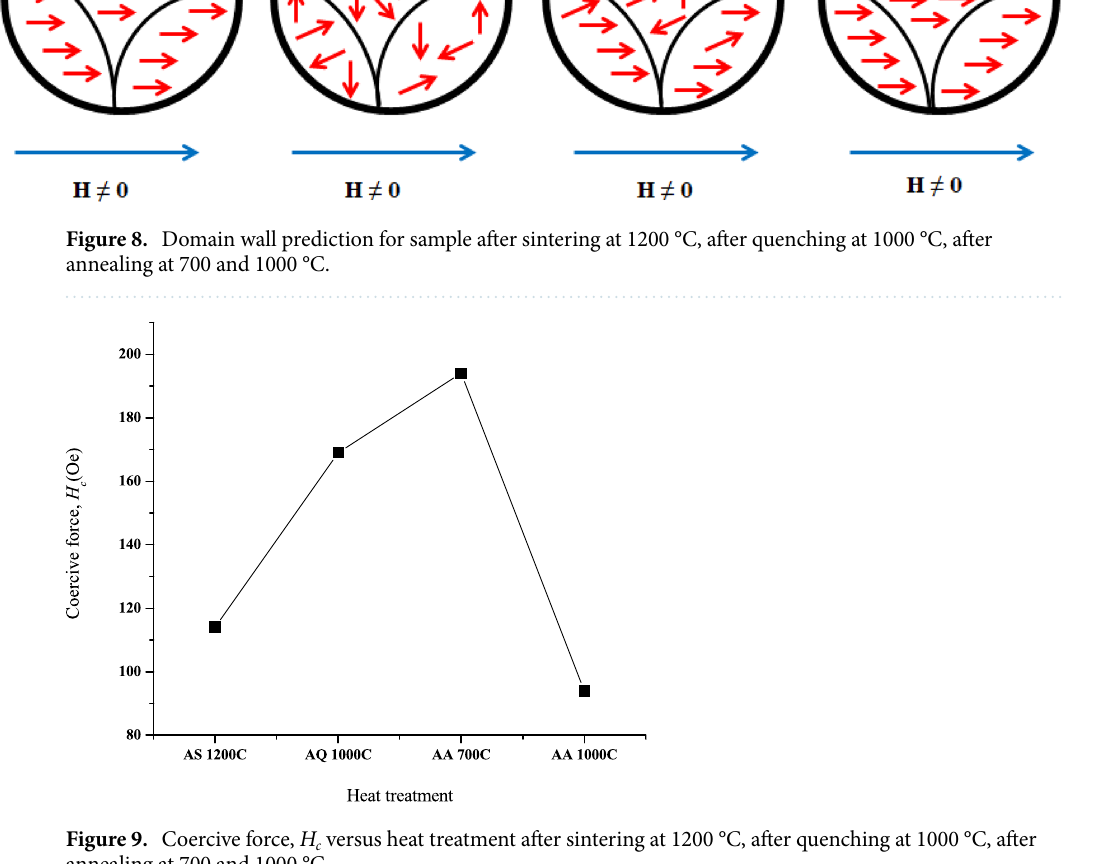
Figure 9. Coercive force, H c versus heat treatment after sintering at 1200 °C, after quenching at 1000 °C, after annealing at 700 and 1000 °C.